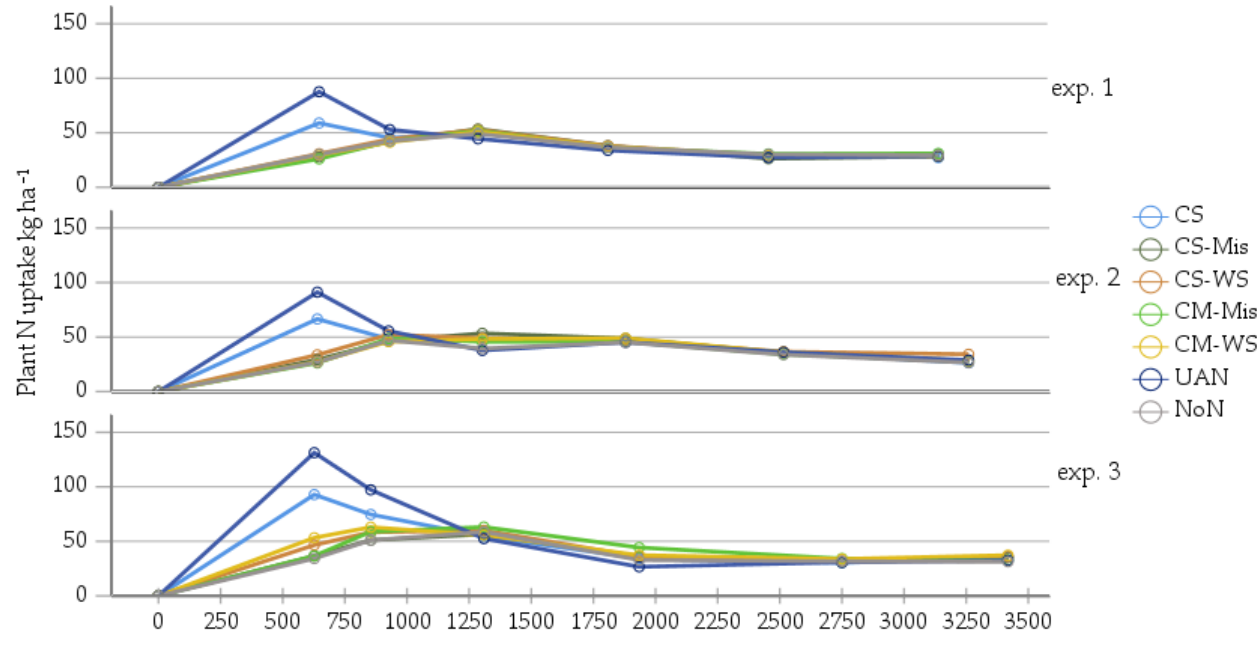
Figure 1. Plant N uptake of ryegrass in relation to harvests (markings) and thermal time (cumulative day degrees above 5 °C) in experiments 1, 2 and 3 for each treatment (CS = Cattle Slurry, CS- Mis = Cattle Slurry- Miscanthus (5 kg to 1 kg), CS-WS = Cattle Slurry-Wheat Straw (8.5 kg to 1 kg), CM- Mis = Cattle Manure from Miscanthus shredded bedding, CM-WS = Cattle Manure from Wheat Straw shredded bedding, UAN = Urea Ammonium Nitrate, NoN = No nitrogen applied).